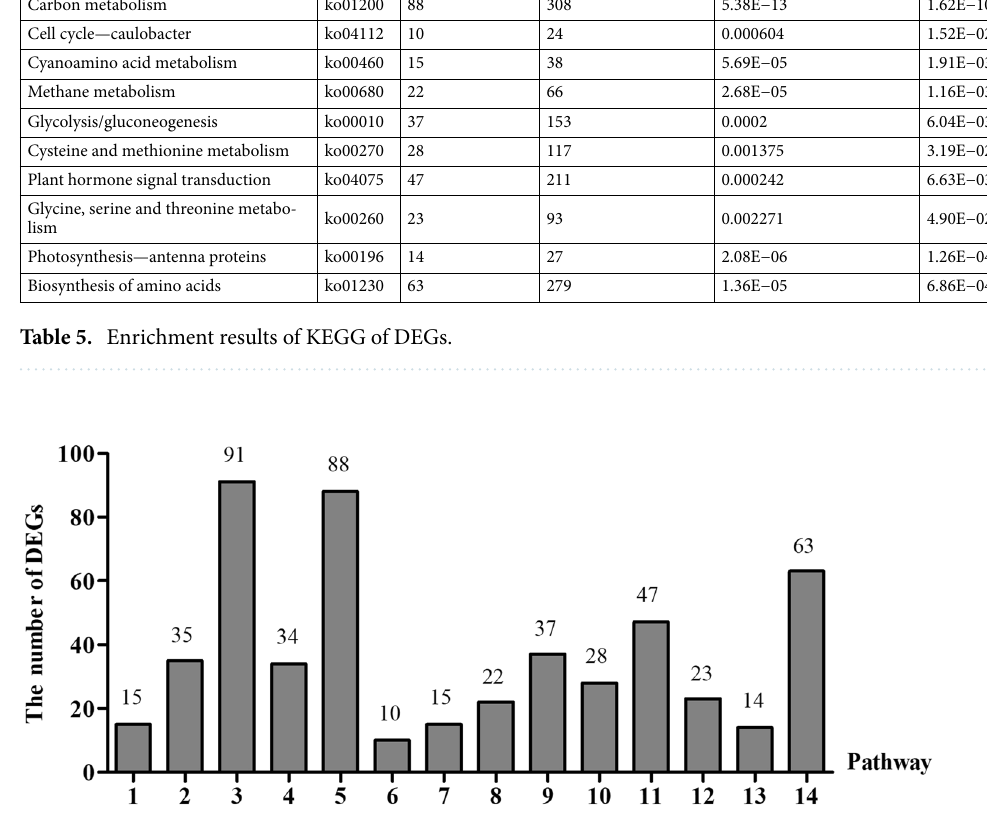
Figure 5. KEGG enrichment of DEGs. 1. Alpha-Linolenic acid metabolism. 2. Carbon fixation in photosynthetic organisms. 3. Ribosome. 4. Glyoxylate and dicarboxylate metabolism. 5. Carbon metabolism. 6. Cell cycle—Caulobacter. 7. Cyanoamino acid metabolism. 8. Methane metabolism. 9. Glycolysis/ gluconeogenesis. 10. Cysteine and methionine metabolism. 11. Plant hormone signal transduction. 12. Glycine, serine and threonine metabolism. 13. Photosynthesis—antenna proteins. 14. Biosynthesis of amino